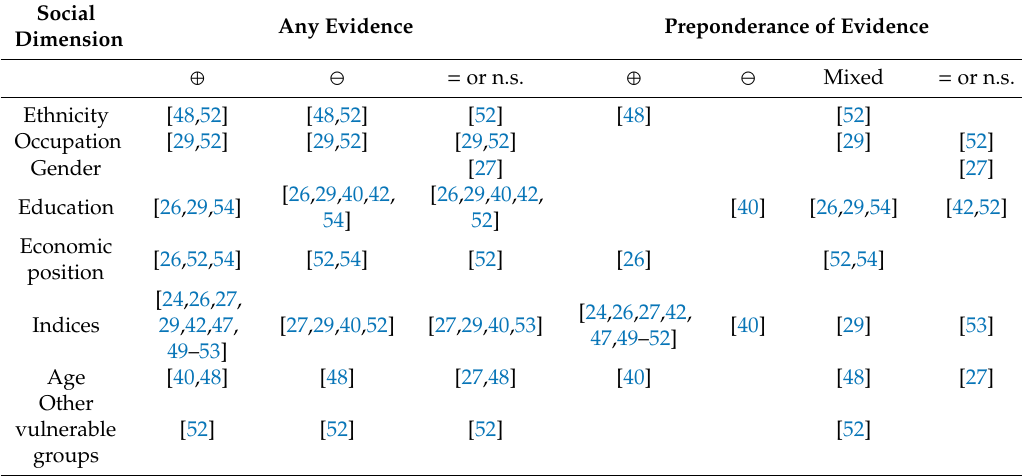
Table 4. Ecological studies at the city or regional